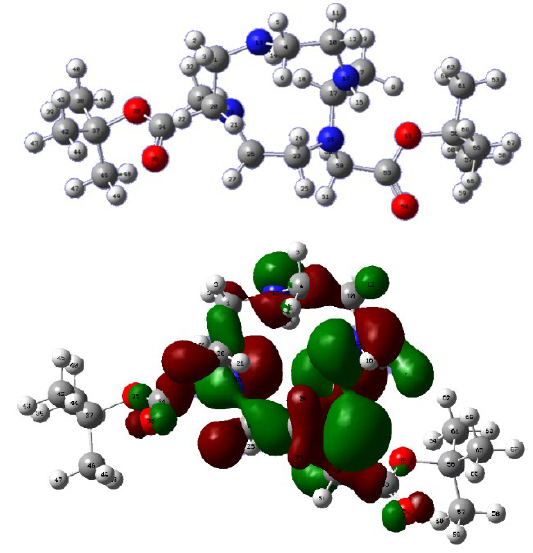
Figure 8. DFT calculations compound 17.